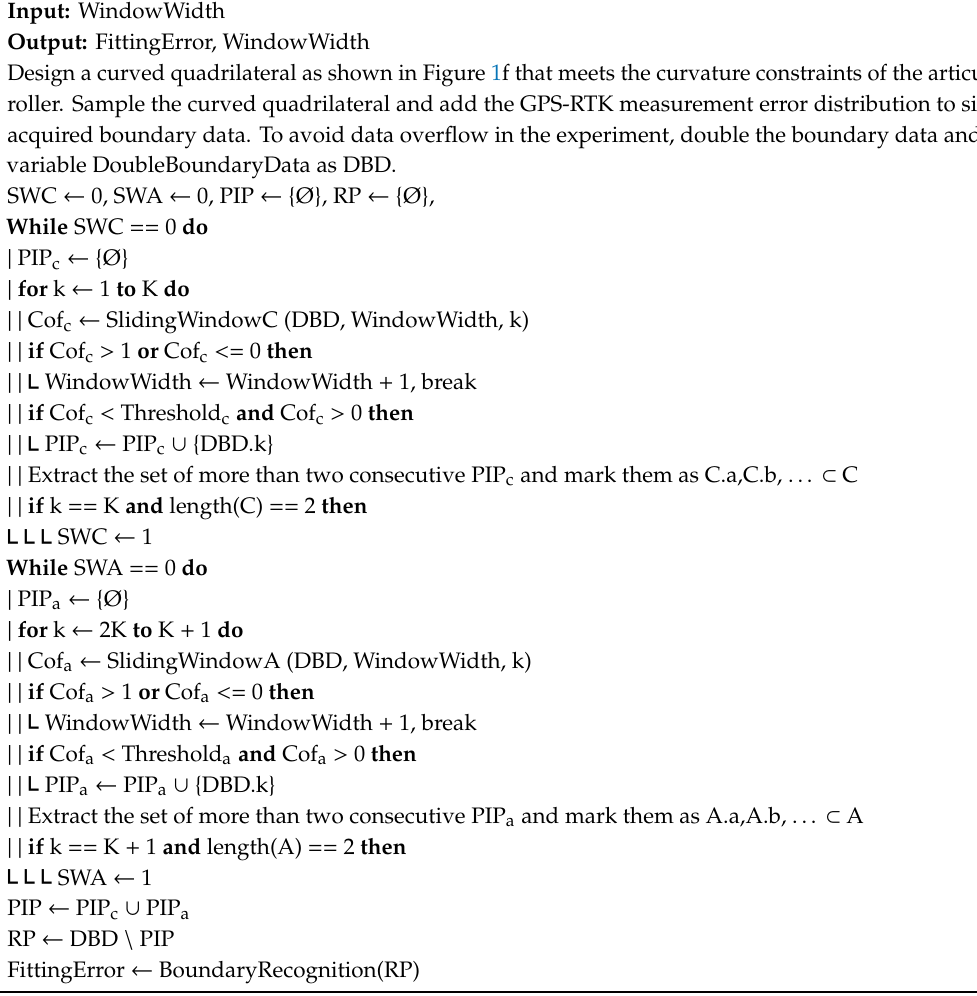
Algorithm 1: Boundary Recognition with BSW